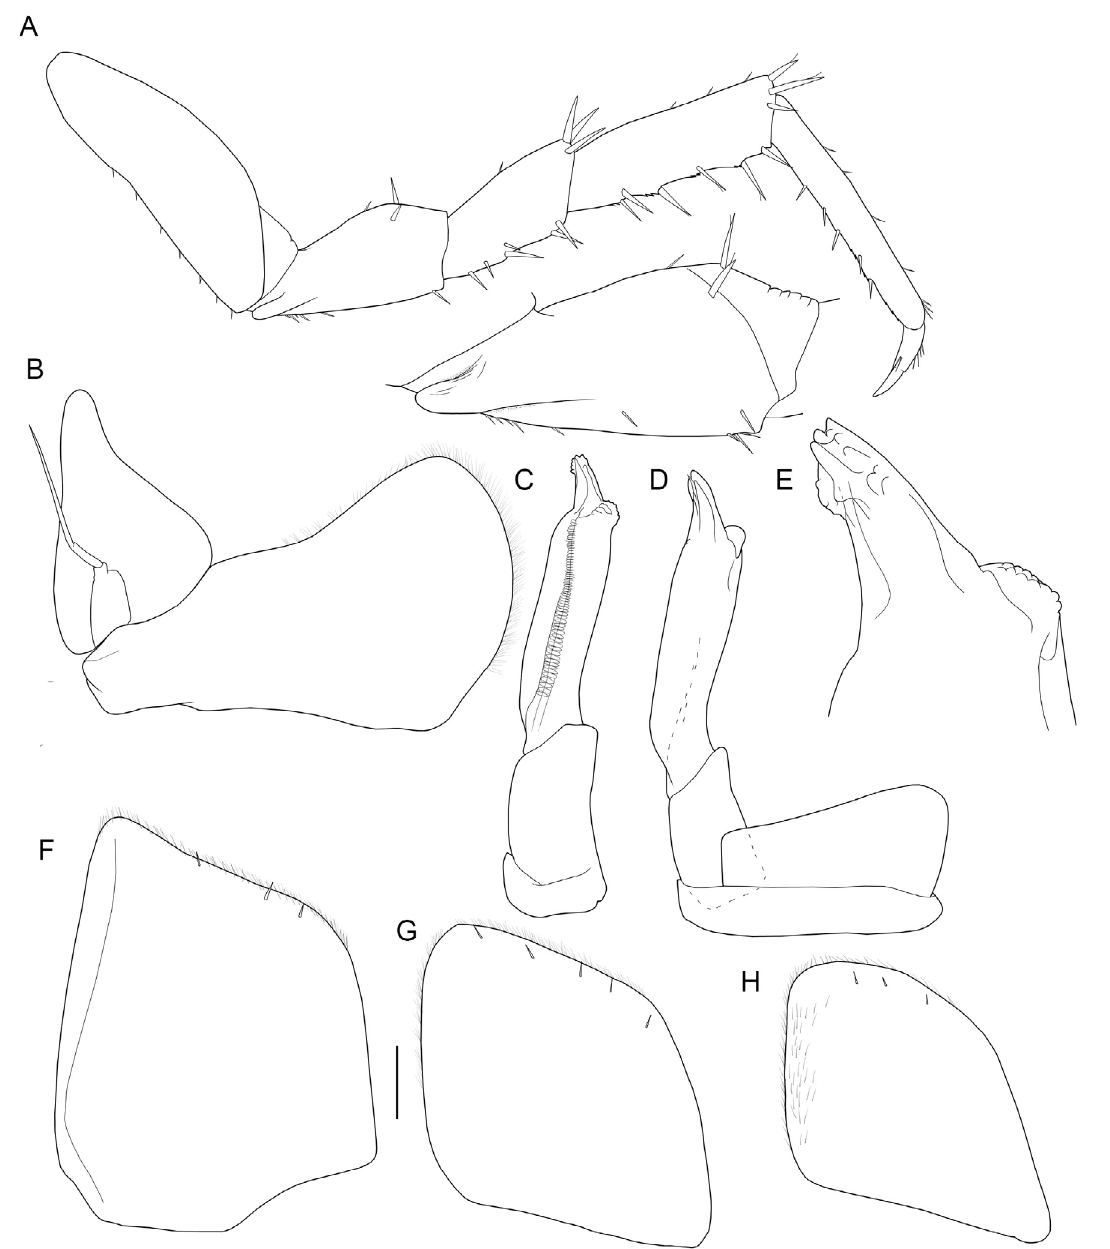
Figure 8. Spelunconiscus septemlacuum sp nov. A : Pereopod 7 and detail of the spur-like structure on the ischium; B : pleopod 1; C – E : pleopod 2; F : pleopod 3; G : pleopod 4; H : pleopod 5. Scale bar: 0.2